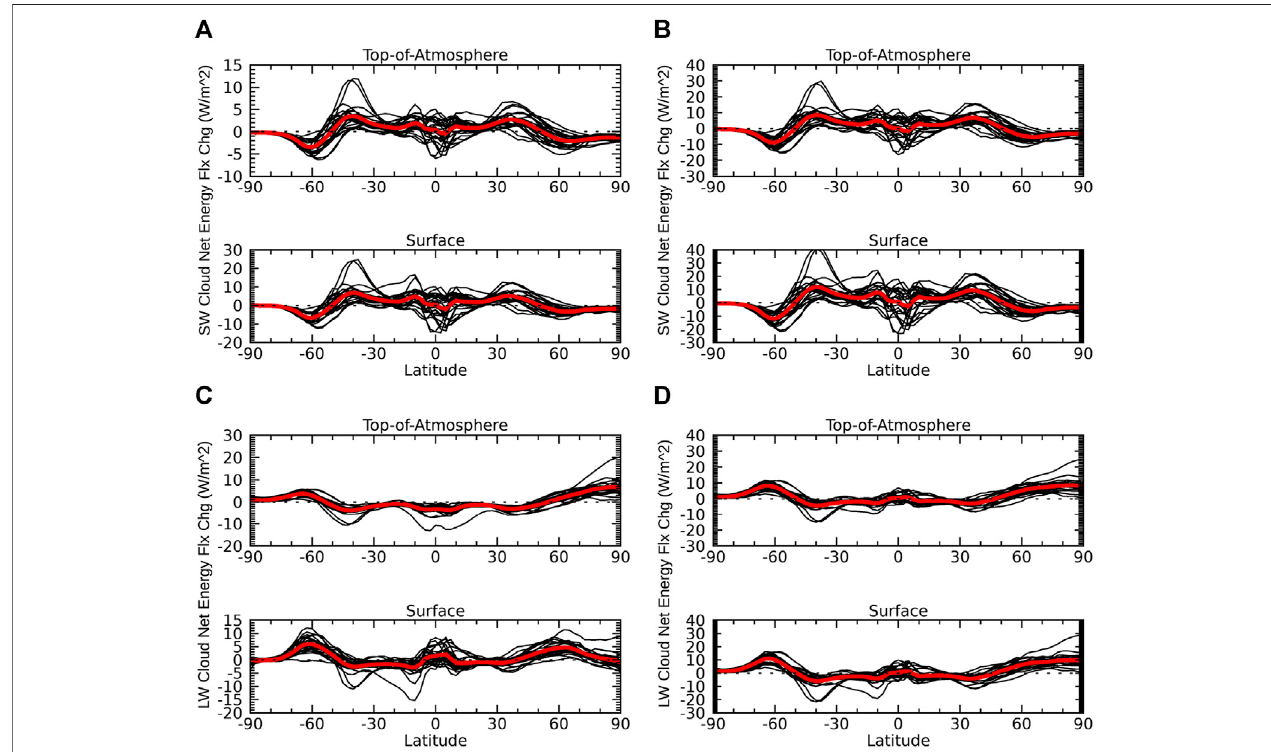
FIGURE 7 | Same as Figure 5 but due to the shortwave and longwave cloud feedbacks.